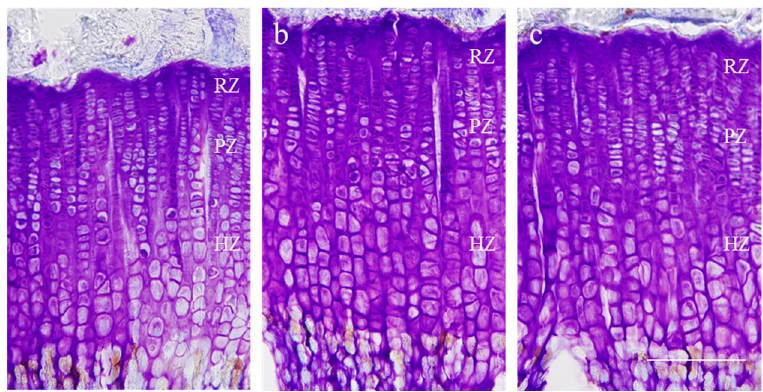
Figure 3. Representative photomicrographs of cresyl violet-stained chondrocytes of the proximal tibial growth plate in rats. ( a ) vehicle treated control group; ( b ) rhGH 200 μ g/kg (s.c.) treated group; ( c ) P. umbrosa 300 mg/kg (p.o.) treated group, RZ: resting zone, PZ: proliferative zone, HZ: hypertrophic zone. The scale bar is 200 μ m.